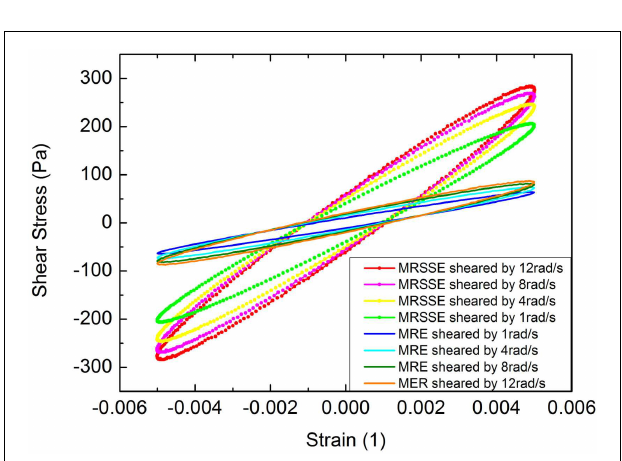
FIGURE 10 |The shear-stiffened effect of MRSSE and MRE .